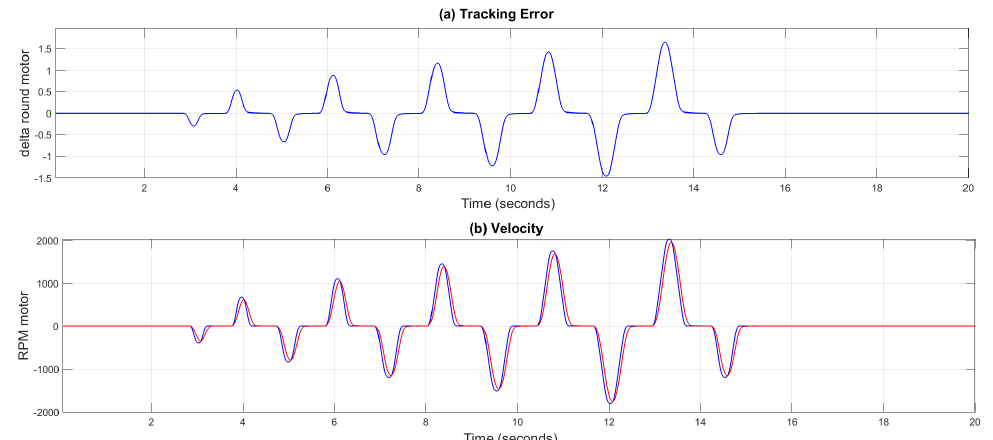
Figure 21. ( a ) Tracking Error, ( b ) Velocity: reference profile (blue line), measured velocity (red line).